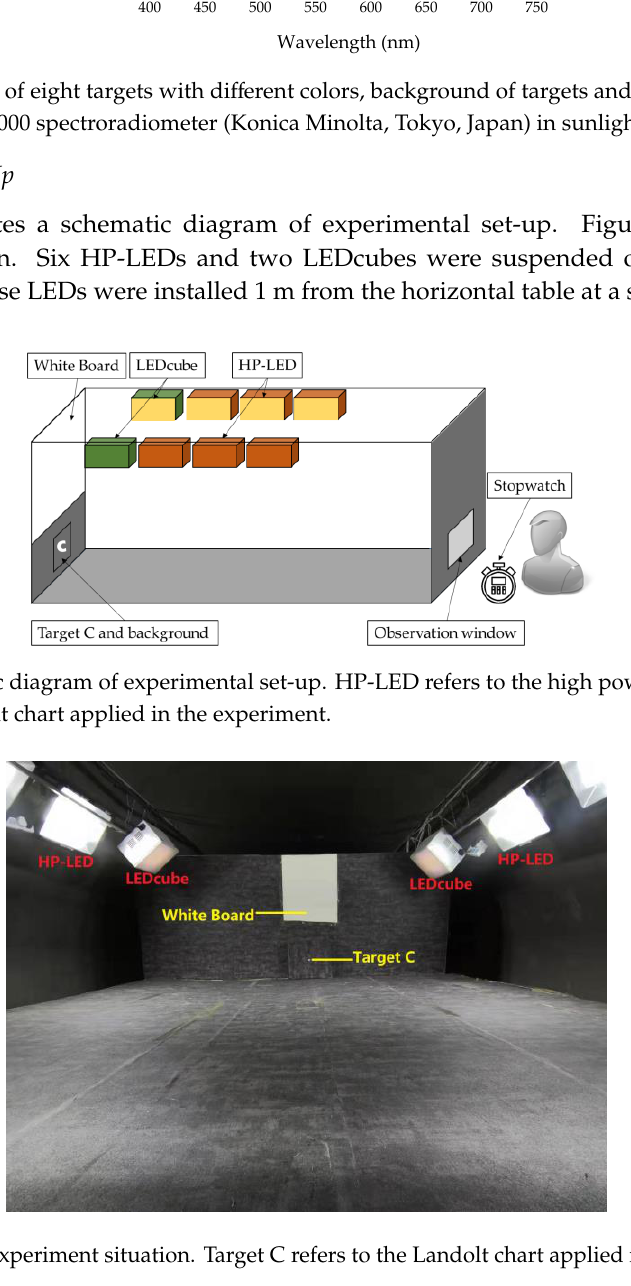
Figure 6. The SPDs of eight targets with different colors, background of targets and tunnel pavement measured by a CS2000 spectroradiometer (Konica Minolta, Tokyo, Japan) in sunlight.